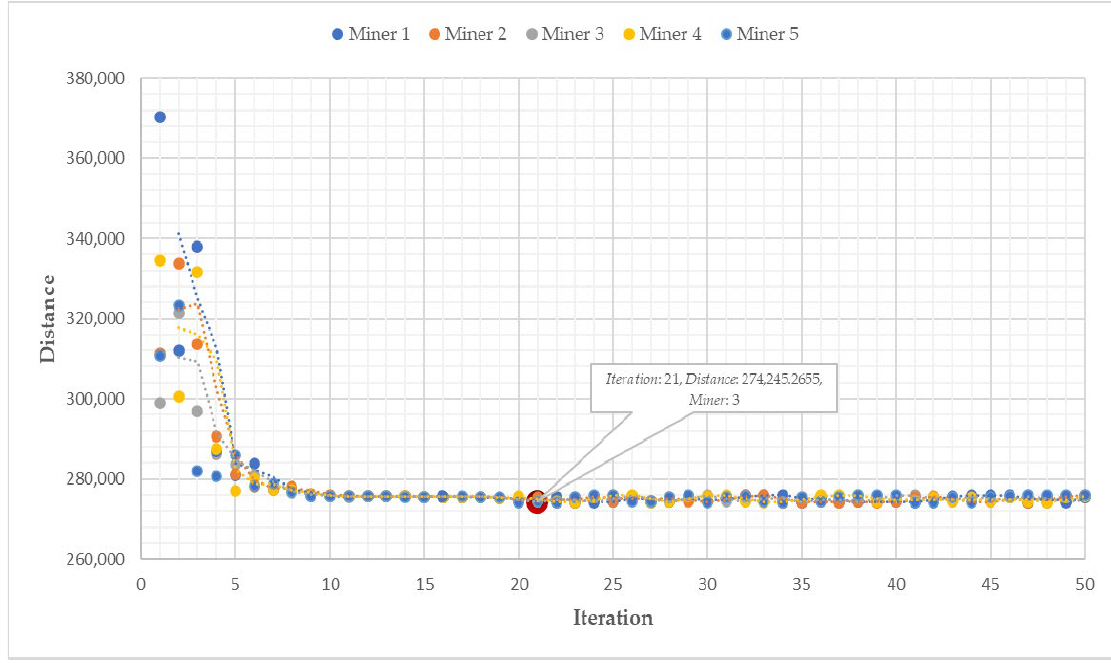
Figure 16. Collaboration of miners to determine the appropriate solution for the optimal-placement- of-resources problem around locations with the possibility of finding the optimal solution (the number of devices was 5000 in a 10-dimensional space).